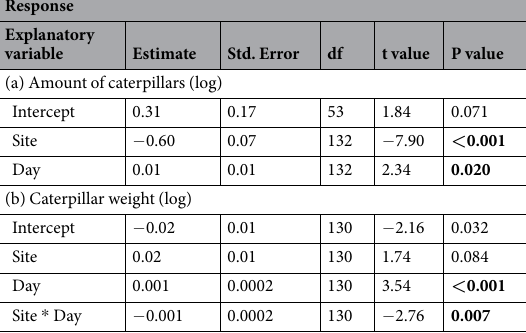
Table 4. Summary of model testing for differences in caterpillar numbers and weight across sites and day of the breeding season, after backward selection. Response variables were log-transformed to achieve normality of residuals. Initial explanatory variables were site, day and site * day interaction, and were dropped if not significant via backward selection (only significant variables are shown). Tree ID was always included as random factor.